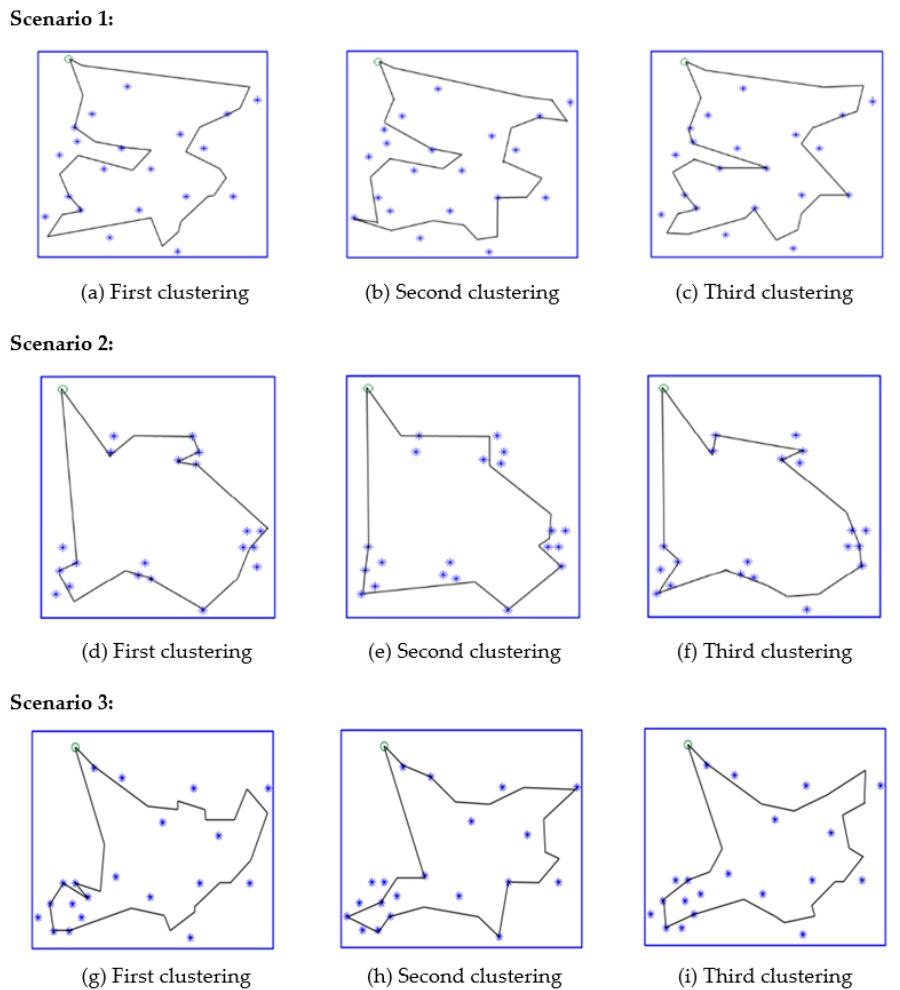
Figure 14. The recharging paths by applying three clustering mechanisms. Three scenarios are considered.